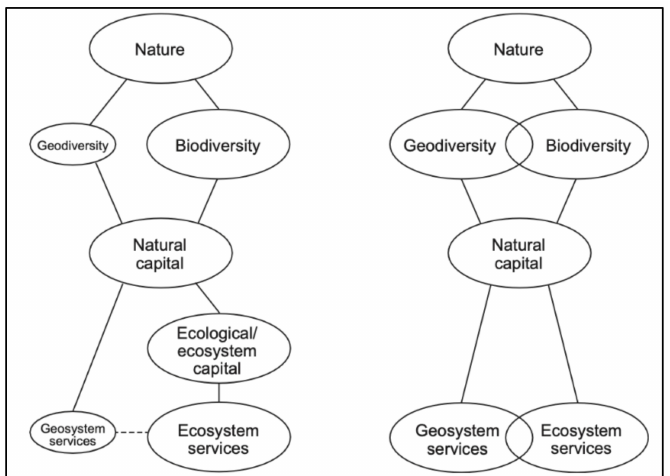
Figure 1. The current position of geosystem services in the prevalent ecosystem services literature is as a smaller counterpart to ecosystem services ( left ), which is inadequate given the many benefits ecosystems and societies derive from geosystem services, and should be reconceptualized as two equally important and interconnected components of geosystem and ecosystem services ( right ). Reproduced from [32] with permission from Elsevier,